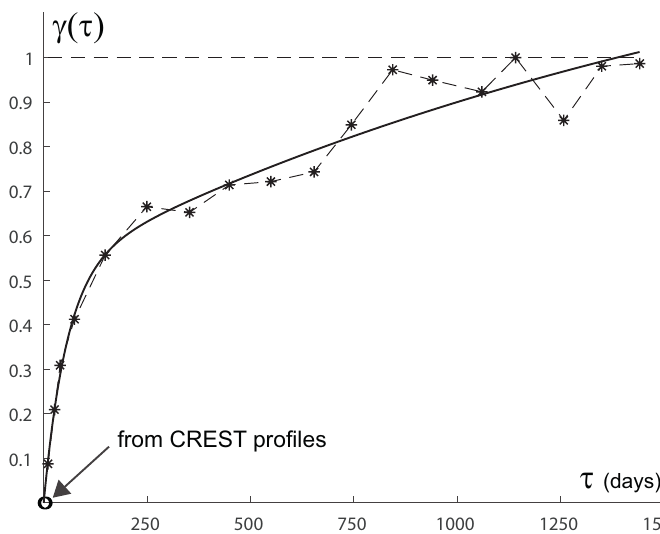
Figure 8. Estimation of the (normalized) temporal variogram from the Coastal Division profiles (plain circles and dashed line), along with the estimation of the short-range variability obtained from the CREST profiles (white circles). The fitted model corresponds to the thick plain line.